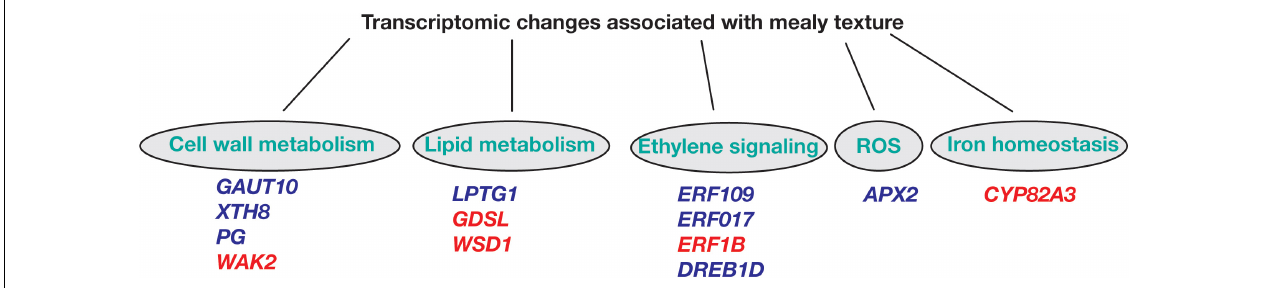
FIGURE 8 | Hypothetical scheme of differentially expressed genes between mealy and normal fruits associated to metabolic pathways leading to mealiness in P. persica fruits. Biological processes of cell wall metabolism, lipid metabolism, ethylene signaling, ROS (reactive oxygen species) and iron homeostasis are represented. Genes highlighted in blue are overexpressed, while red colored genes are downregulated in mealy fruits. GAUT10: GALACTURONOSYLTRANSFERASE-like 10; XTH8: XYLOGLUCAN ENDOTRANSGLUCOSYLASE/HYDROLASE PROTEIN 8; PG: POLYGALACTURONASE; WAK2: WALL-ASSOCIATED RECEPTOR KINASE 2; LPTG1: NON-SPECIFIC LIPID TRANSFER PROTEIN GPI-ANCHORED 1; GDSL esterase/lipase; WSD1: O-ACYLTRANSFERASE; ERF: ETHYLENE-RESPONSIVE FACTOR; DREB1D: DEHYDRATION-RESPONSIVE ELEMENT BINDING 1D; APX2: L-ASCORBATE PEROXIDASE 2; CYP82A3: CYTOCHROME P450 82 A3